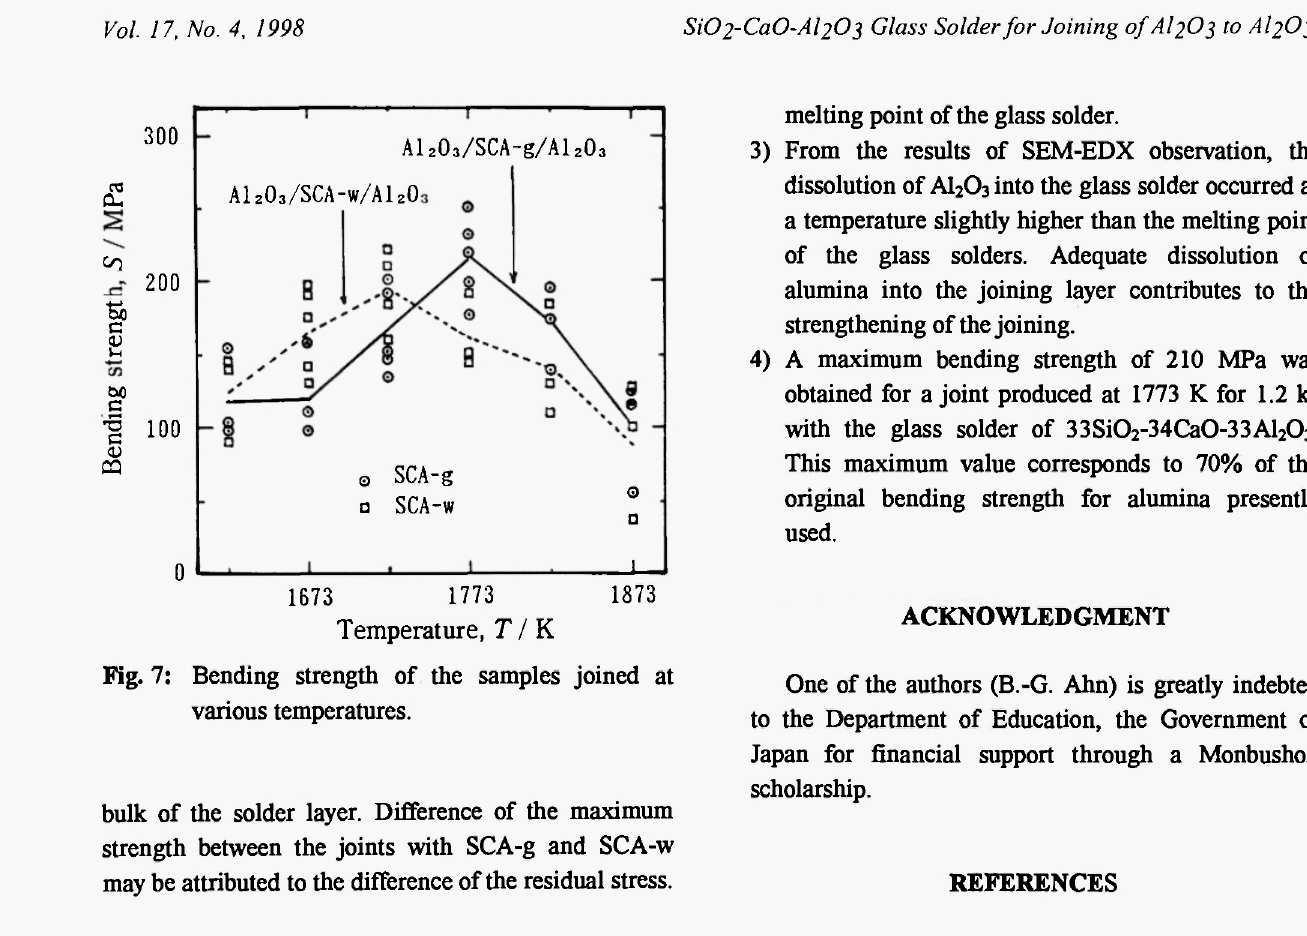
bulk of the solder layer. Difference of the maximum strength between the joints with SCA-g and SCA-w may be attributed to the difference of the residual